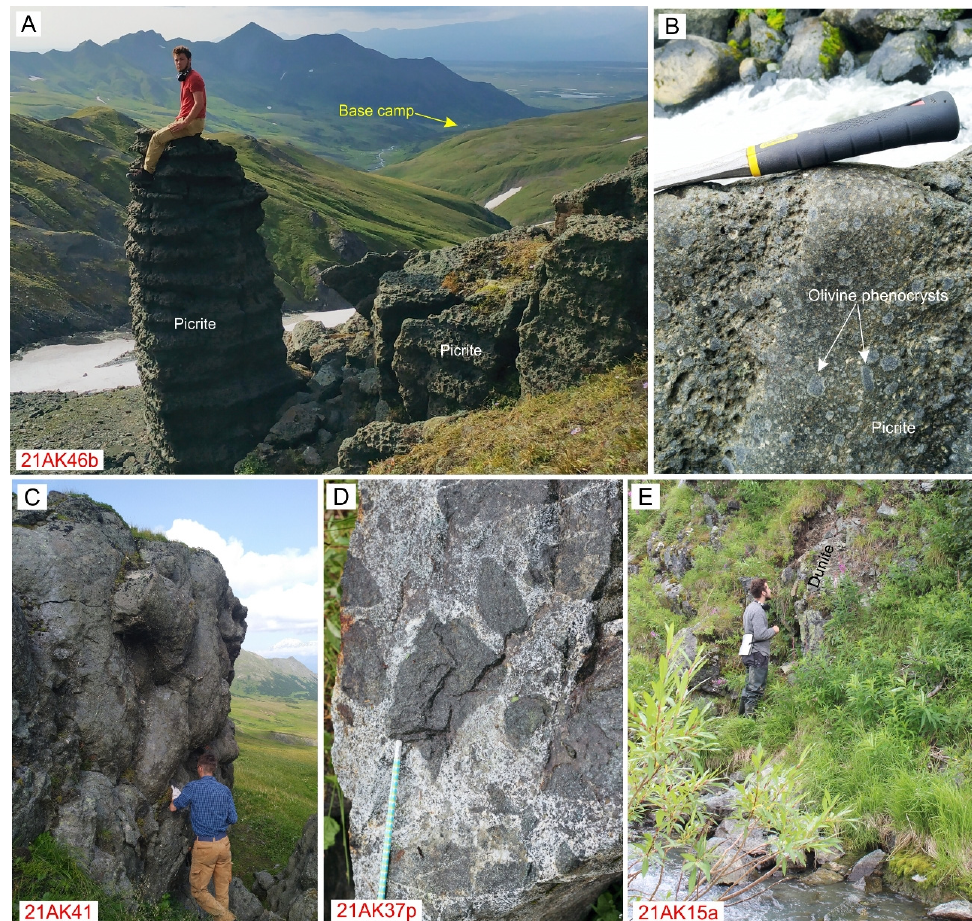
Figure 3. Field photographs of the outcrops with the labeled samples. ( A ) comb-like weathered bedrock picrite; ( B ) olivine phenocrysts on a water-polished surface of picrite; ( C ) an outcrop of a differentiated basalt flow; ( D ) a boulder of breccia-like gabbroic rock; ( E ) an outcrop of weathered dunite, Shumniy creek brink. Photograph ( E ) is by Elizaveta Grigor’eva.